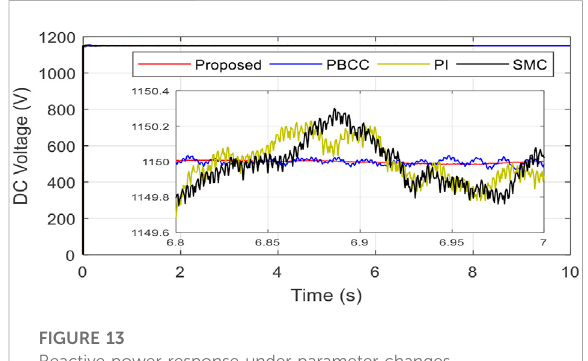
FIGURE 13 Reactive power response under parameter changes.